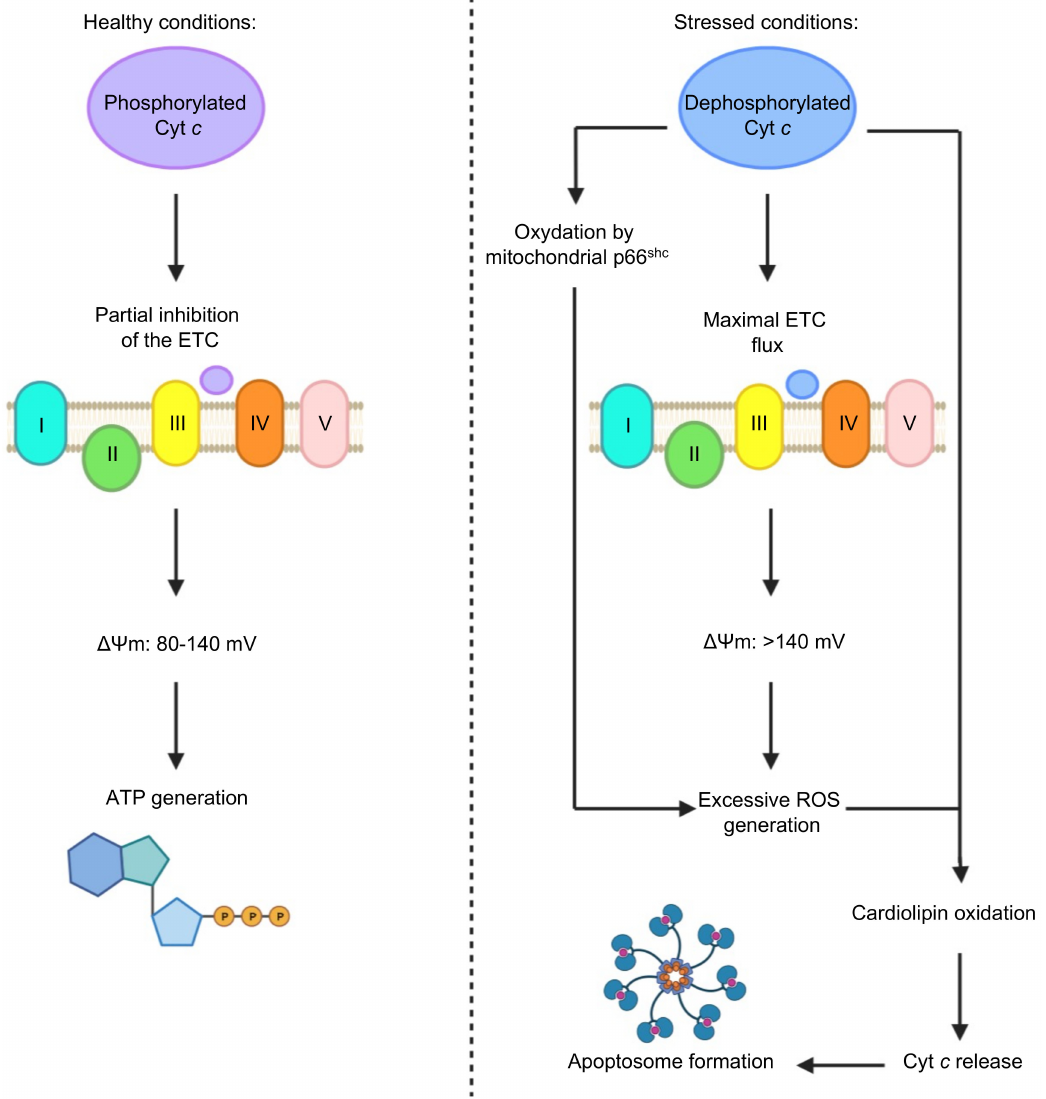
Figure 10. Schematic view of the effects of phosphorylated and dephosphorylated Cyt c in the mitochondria. (Image was created using